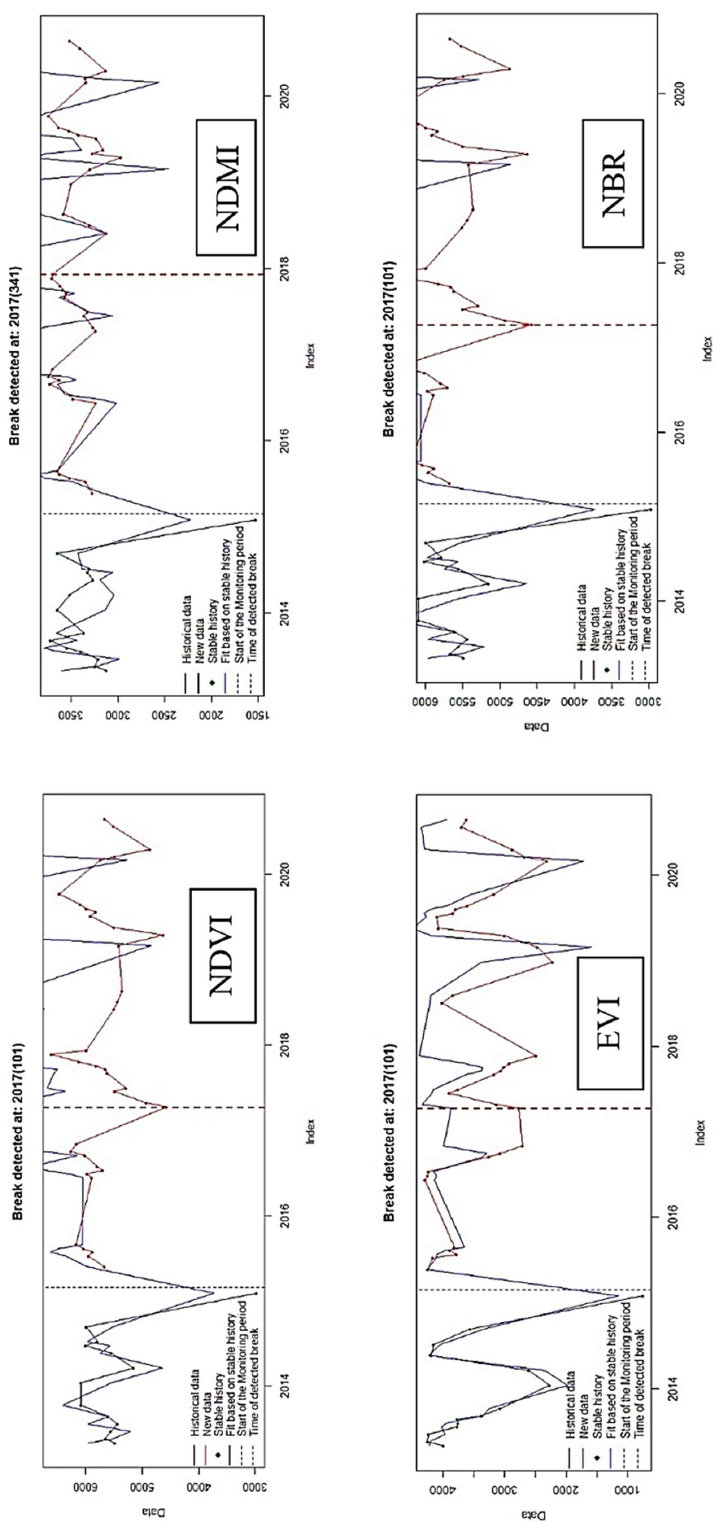
Figure 6. NDVI, NDMI, EVI, and NBR time series profiles using pixel-level analysis of the BFAST- Monitor algorithm over study area B.